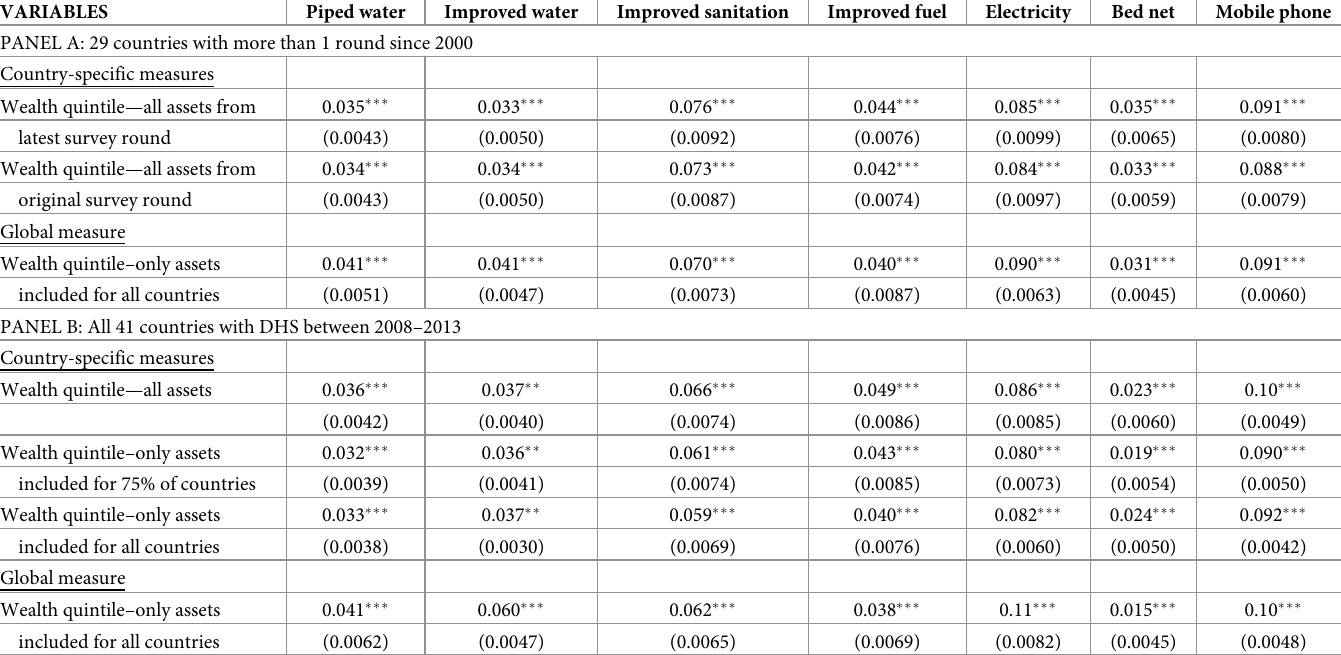
Table 4. Pooled multivariable regression estimates of the association between wealth and EHA access, across different definitions of the wealth index; for countries with multiple rounds (Panel A) and latest data from all countries (Panel